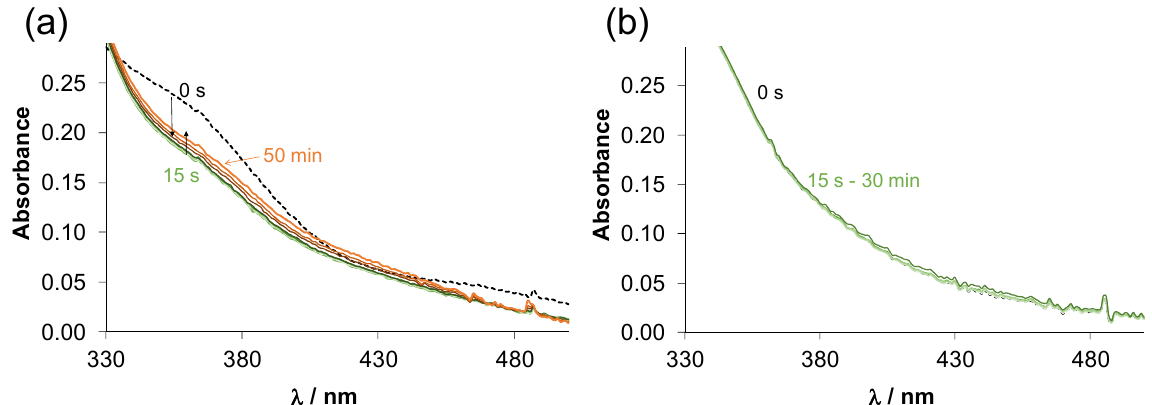
Figure 6. Time-dependence of UV-vis absorption spectra recorded for ( a ) complex 1 and ( b ) complex 2 in the presence of 0.5 equiv. HSA at pH = 7.4. { T = 25.0 °C, c complex = 100 μM, pH = 7.40 PBS’ buffer; l = 1 cm}.